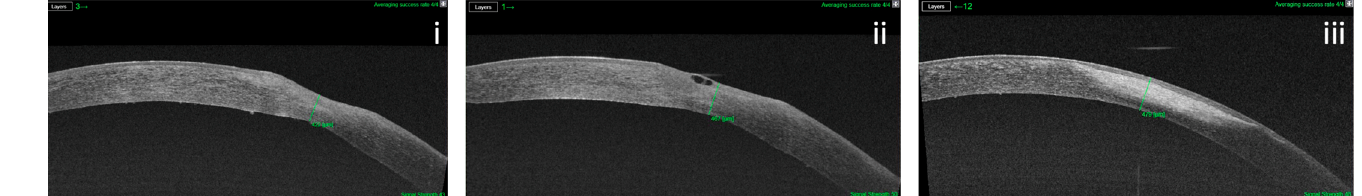
Figure 2. Variation of ulcer’s depth in a patient with post-herpetic NK treated with rh-NGF. The corneal thickness was calculated with OCT software at baseline: ( i ) 4 weeks, ( ii ) and 8 weeks ( iii ).